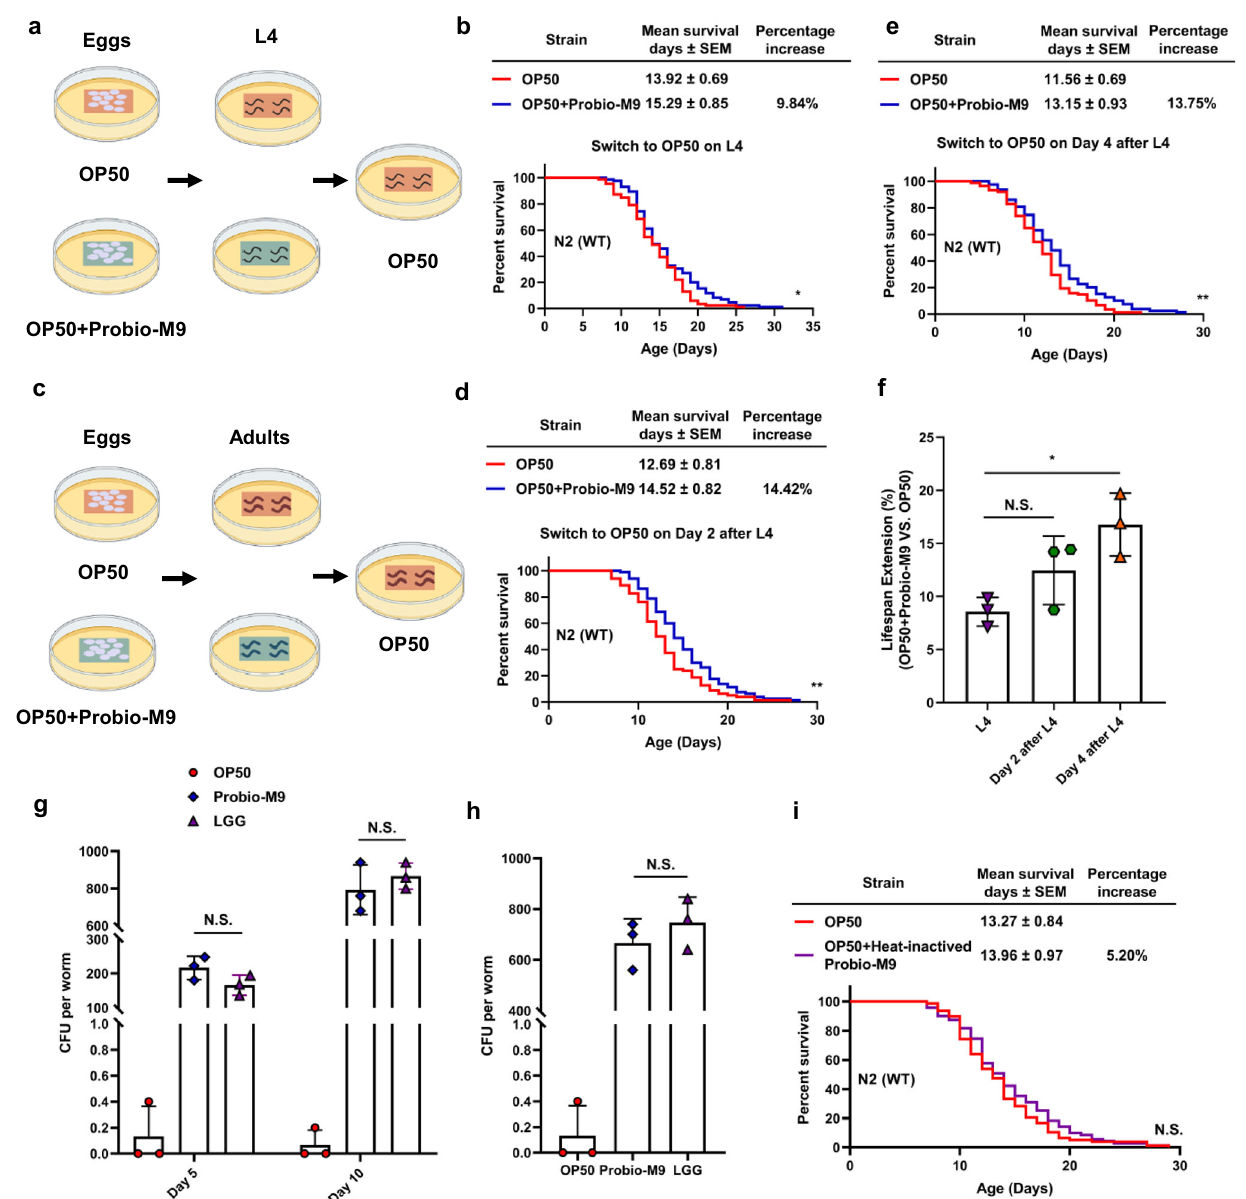
Fig. 3 Viability and host accumulation capacity of Probio-M9. a , c Schematics illustrate the method and bacteria used in each assay. After bleaching, eggs were transferred to bacterial lawn (OP50 or OP50 + Probio-M9) and allowed to develop to late L4 stage or adulthood (day 2 or day 4 after L4 stage). b , d , e Survival curves of OP50 or OP50 + Probio-M9-fed to late L4 stage ( b ), day 2 after L4 stage ( d ) and day 4 after L4 stage ( e ) ( N = 90 worms, p < 0.05, Log rank test). f OP50 + Probio-M9 feeding at day 4 after L4 stage signi fi cantly lengthened lifespan, but not at day 2 after L4 stage, compared with those fed with OP50 + Probio-M9 to L4 stage ( N = 3 biologically experiments, p < 0.05, Student ’ s t test). g Colony forming indicated that Probio-M9 was attached to the C. elegans gut similar to LGG ( N = 3 biologically experiments, p > 0.05, Student ’ s t test). Day 5 or day 10 worms were collected from the NGM plates lawned with the test bacterial and processed to count the number of bacterial CFU, expressed as CFU per worm. OP50 and LGG were used as control. h Accumulation of the C. elegans gut by Probio-M9. Worms were fed with Probio-M9 or control (OP50 and LGG) for 10 days, and then transferred them to new plates lawn with OP50. After 3 days, the number of CFU in the worm gut was calculated, expressed as CFU per worm, and the results indicated that Probio-M9 was still attached to C. elegans gut ( N = 3 biologically experiments, p > 0.05, Student ’ s t test). In f – h , values are presented as the mean ± SEM. i Heat-inactivated Probio-M9 (95 °C for 30 min) failed to extend the lifespan of wild-type N2 worms ( N = 90 worms, p > 0.05, Log rank